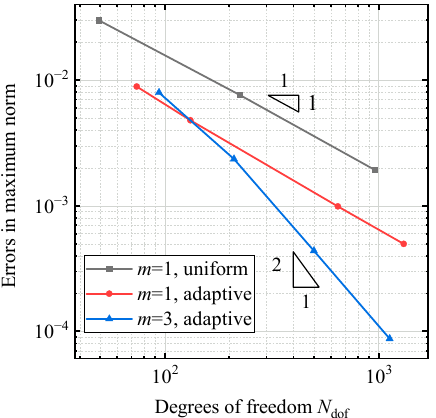
Figure 18. Convergence rates of uniform refinement and adaptive refinement.